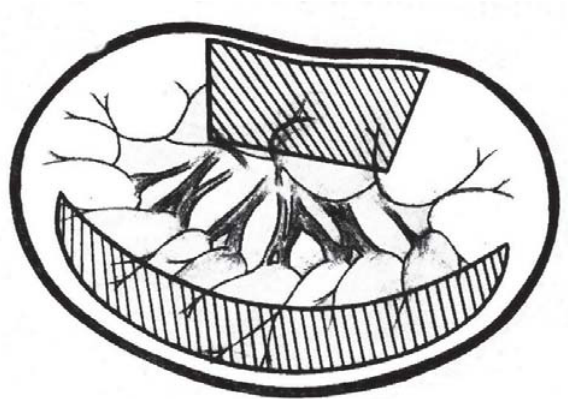
Fig. 5 - Prótese mitral com preservação dos elementos do sistema subvalvar: excisão parcial da cúspide anterior e redução da cúspide posterior conservando-se as suas bordas copiado de David TE (Ann Thorac Surg. 1986;41(6):680-2); (Évora et al., Rev Bras Cir Cardiovasc. 1988;3(1):36-49)